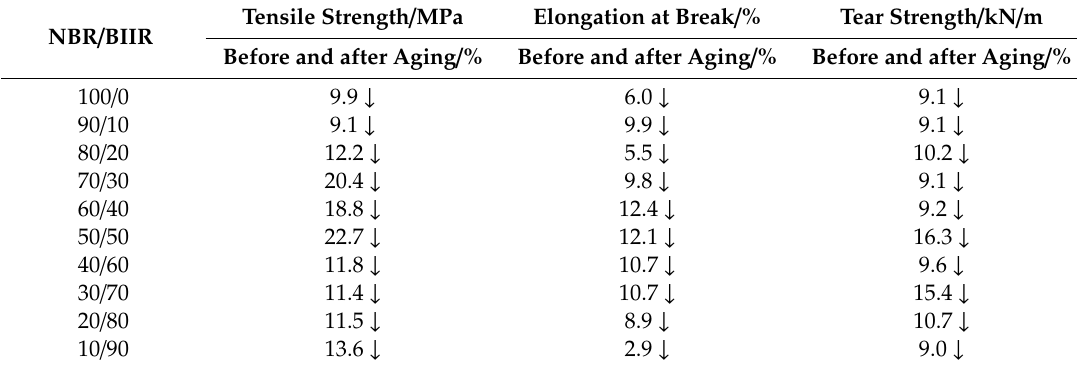
Note: Property variation percentage during aging = (after aging – before aging)/before aging 100%;